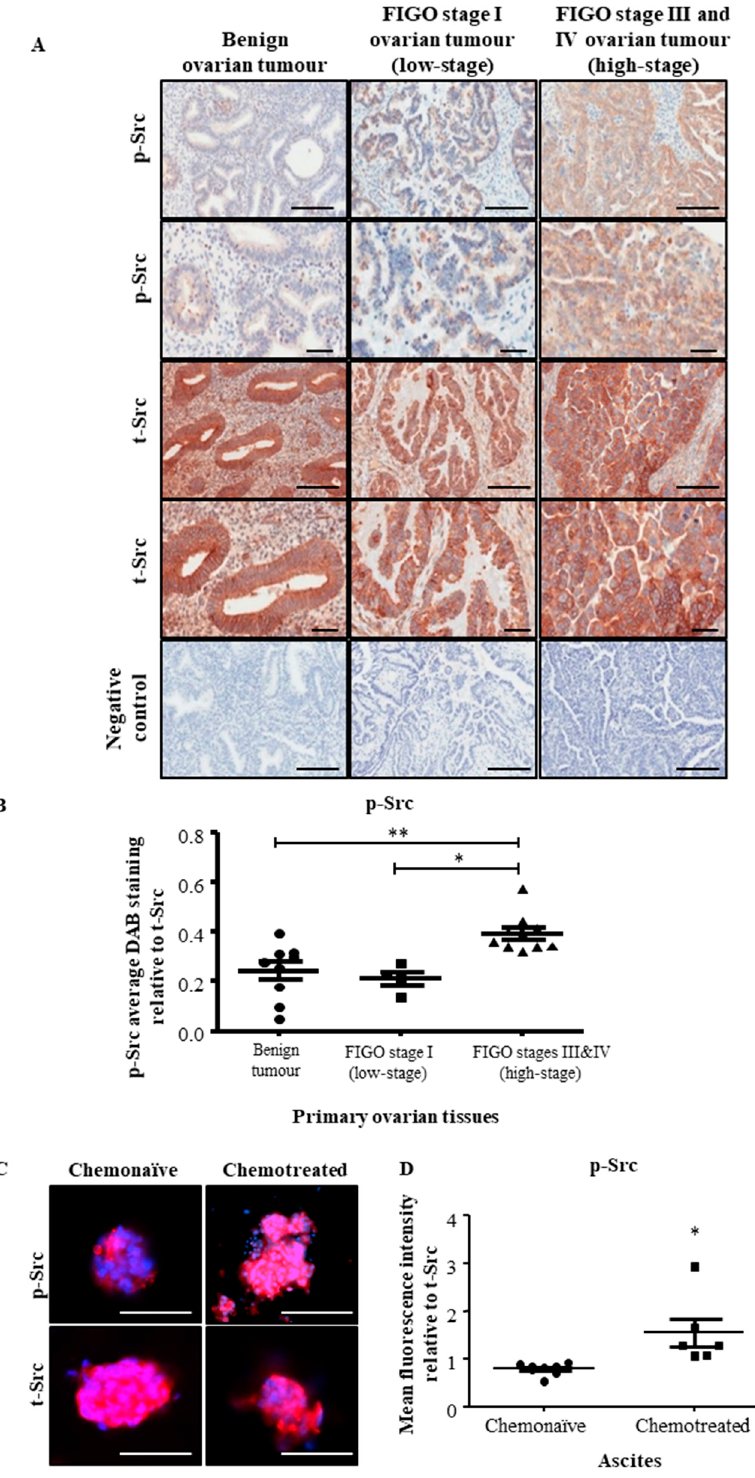
Figure 1. Late-stage and chemotherapy treated ovarian cancer patient samples have greater level of p-Src than early-stage and chemonaïve patients. ( A ) Representative images of p-Src and t-Src staining in primary ovarian benign tumours, FIGO stage I (low-stage) and III/IV (high-stage) serous ovarian cancer patients. Magnification 200× scale bar = 200 µM and 400× scale bar = 60 µM. ( B ) Quantification of p-Src and t-Src DAB staining was performed using Fiji software. Results are displayed as overall average DAB reading of p-Src relative to t-Src of the same samples ± SEM. ( C ) Expression and localization of the Src pathway activation was evaluated by immunofluorescence in non-adherent tumour cells derived from the ascites of chemonaïve and chemotreated recurrent serous ovarian cancer patients. Staining was visualized using the secondary Alexa 590 (red) and nuclei were detected by DAPI (blue) staining. Images are representative of n = 8 chemonaïve and n = 6 chemo-treated ascites-derived cells. Magnification 400× scale bar = 250 µM. ( D ) Quantification of t-Src and p-Src fluorescent intensities was determined using Fiji software. Results are displayed as average fluorescent intensity value of p-Src relative to t-Src of the same ascites sample ± SEM. Significance is indicated by * p < 0.05, ** p < 0.01.